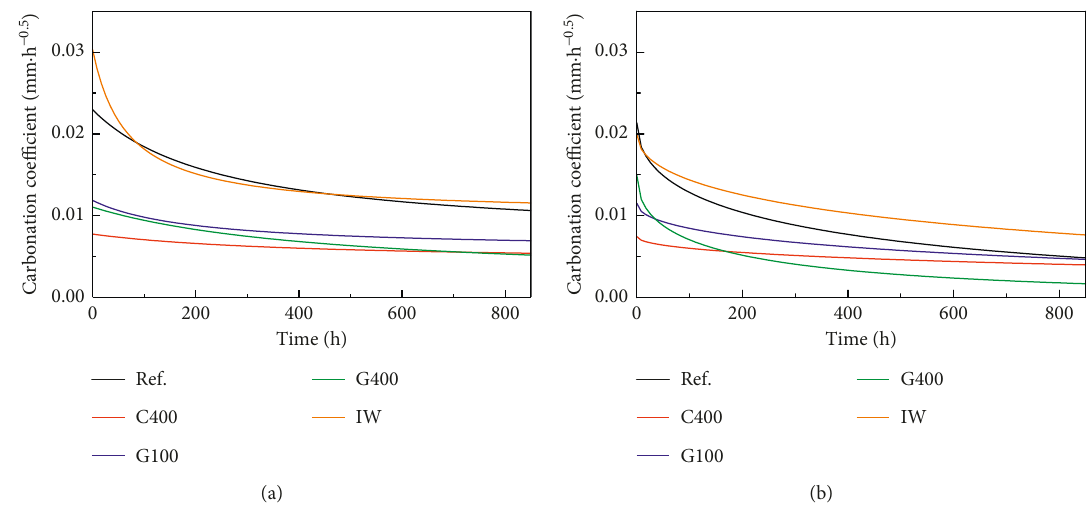
Figure 5: Changes of carbonation coefficient with increasing time. (a) Results obtained from (3). (b) Results obtained from